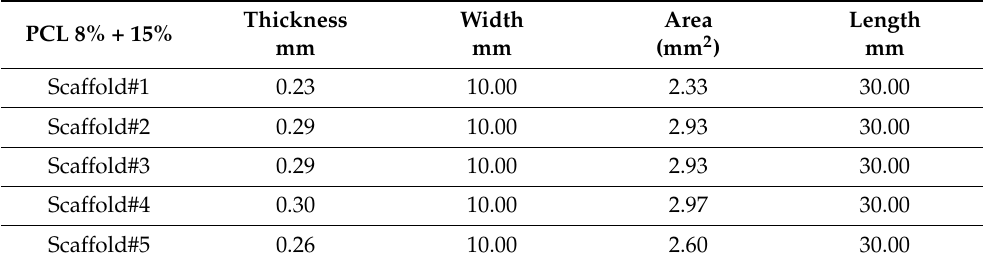
Table 4. Properties of aligned PCL scaffolds for mechanical